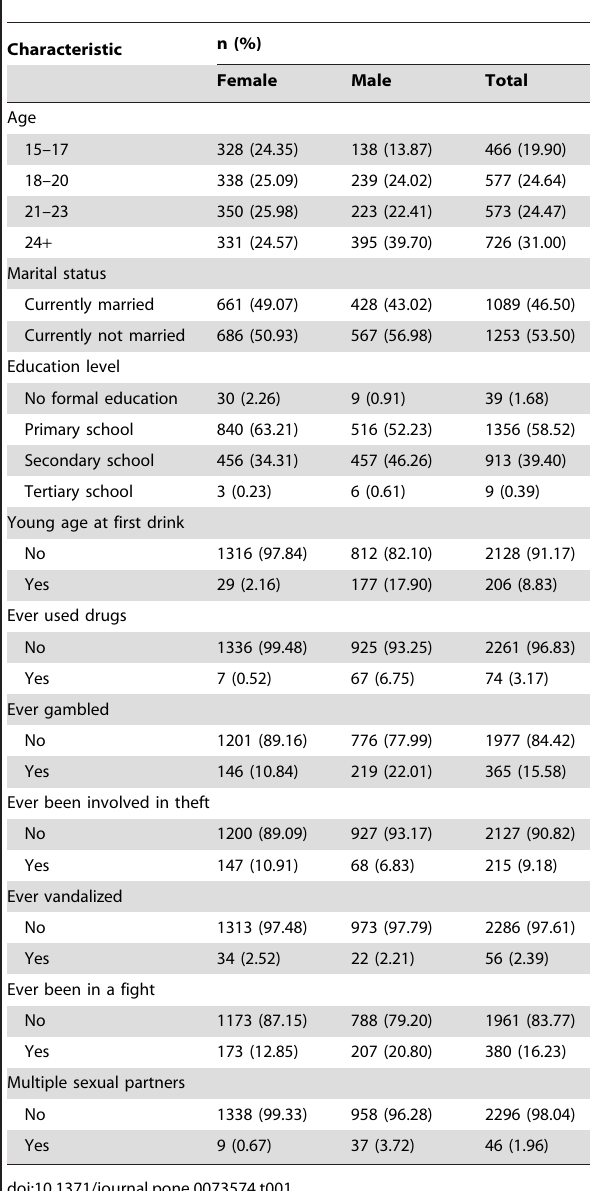
Table 1. Sociodemographic and risky behavior characteristics of the study